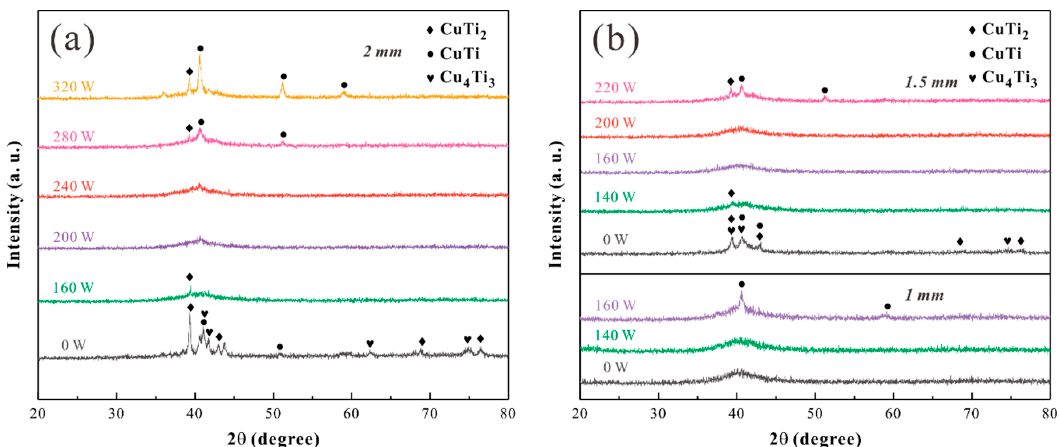
Figure 2. X-ray di ff raction (XRD) patterns of samples with ( a ) 2 mm treated under di ff erent laser Figure 2. X-ray diffraction (XRD) patterns of samples with ( a ) 2 mm treated under different laser powers; ( b ) 1.5 mm and 1 mm treated under di ff erent powers; ( b ) 1.5 mm and 1 mm treated under different powers.